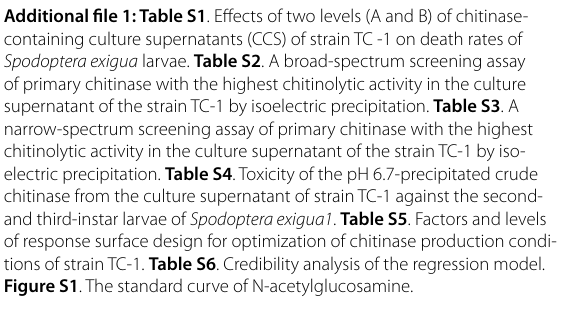
Figure S1 . The standard curve of